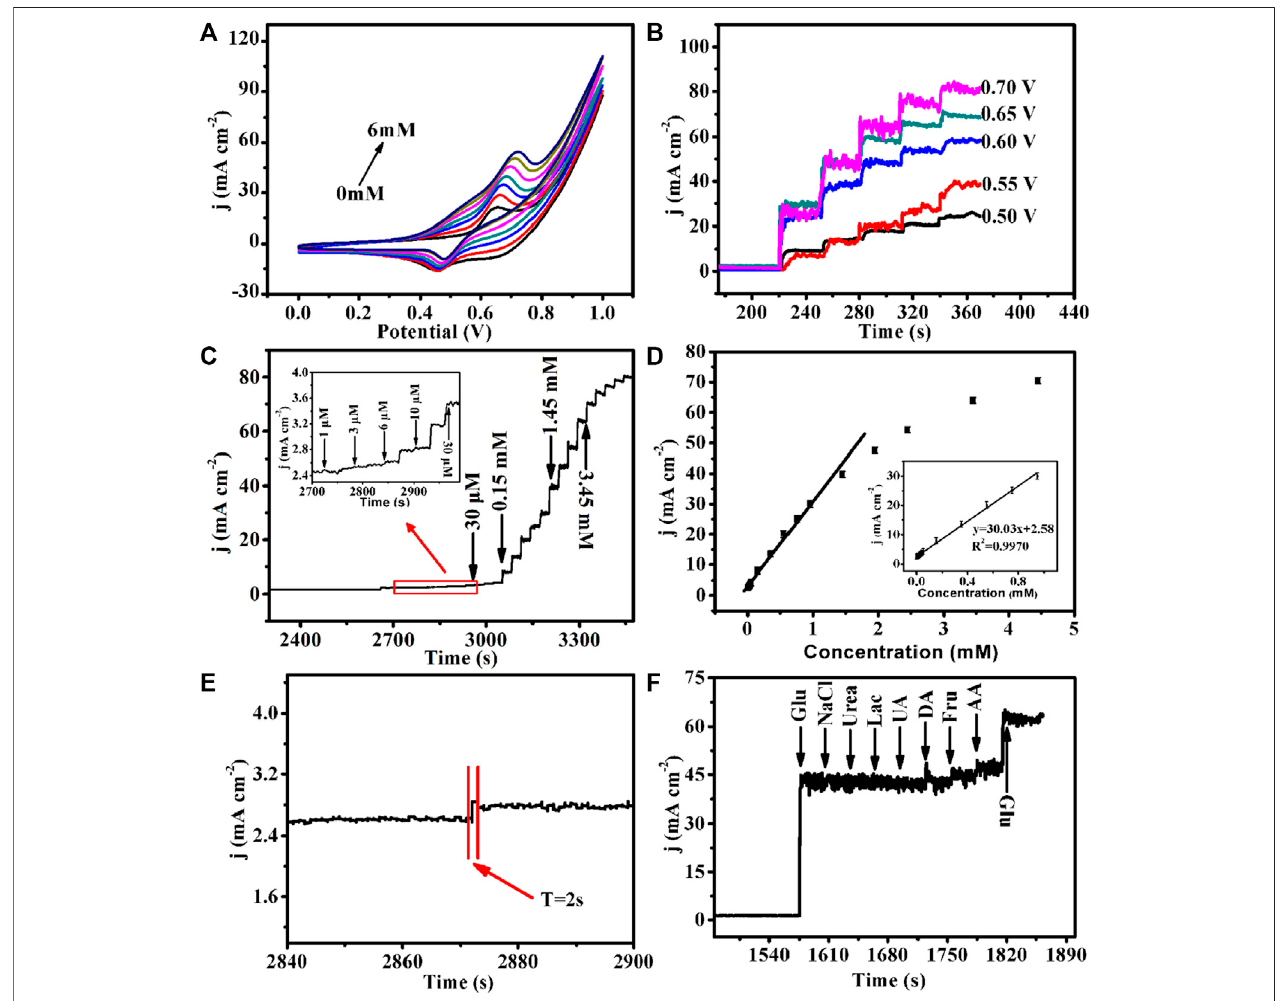
FIGURE4 |(A) Cu-MOF/CFin0.1MNaOHwiththepresenceofvariedGluconcentrations:0,1,2,3,4,5,and6mM(frominnertoouter)atascanrateof50mVs − 1 . (B) AmperometricresponsesoftheCu-MOF/CFelectrodeatdifferentpotentials(from0.50to0.7V)withcontinuousadditionof1mMGluin0.1MNaOH. (C) Amperometric responseofCu-MOF/CFwithsuccessiveadditionofGluin0.1MNaOH(inset:thecurrentresponseoftheelectrodetowardtheadditionofGlufrom1 μ Mto30 μ M)and (D) Correspondingcalibration curveofCu-MOF/CF electrodetosuccessiveadditionsofGluat0.65Vin0.1MNaOH. (E) Ampli fi cationoftheCu-MOF/CF amperometric response curve. (F) Amperometric response of the Cu-MOF/CF electrode toward the addition of Glu (1 mM) with various interfering species (1 mM) in 0.1 M NaOH.